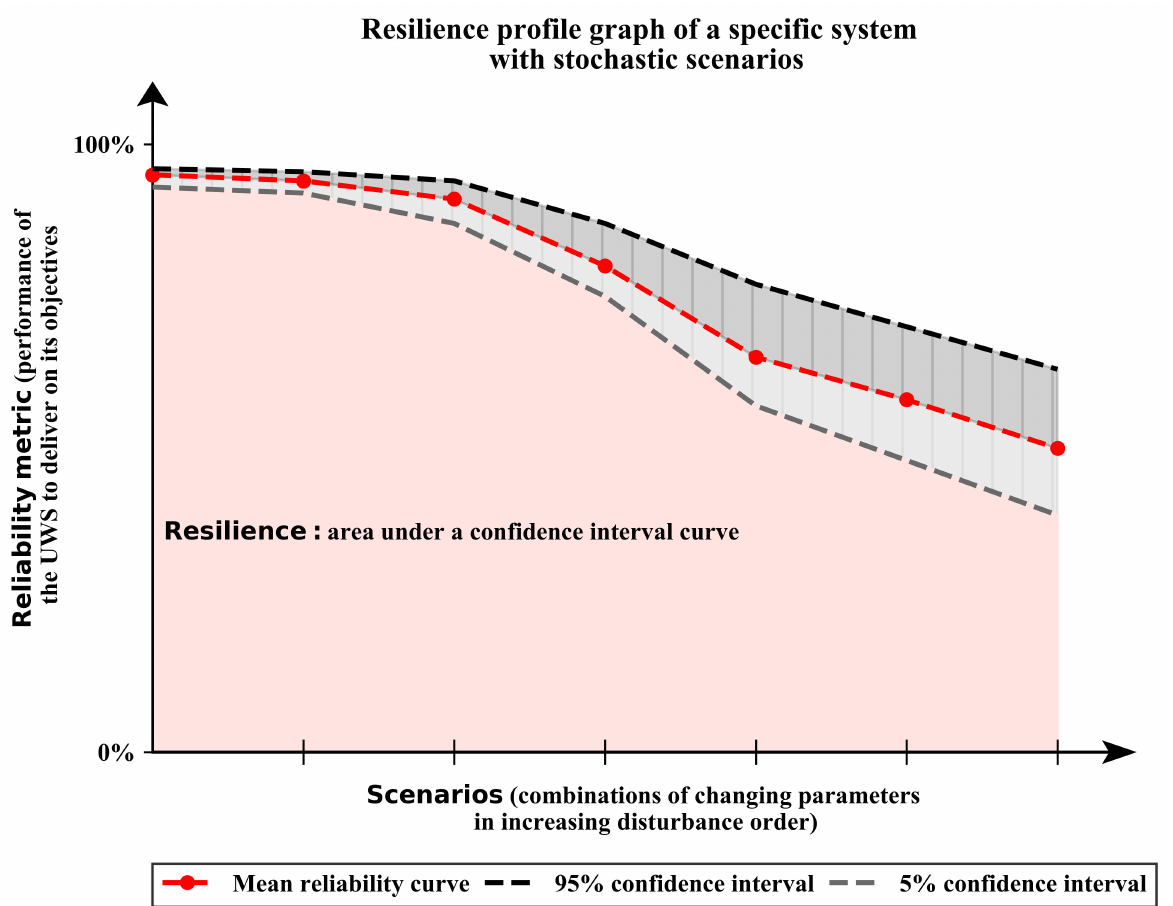
Figure 3. Quantifying uncertainty in resilience estimation of a specific